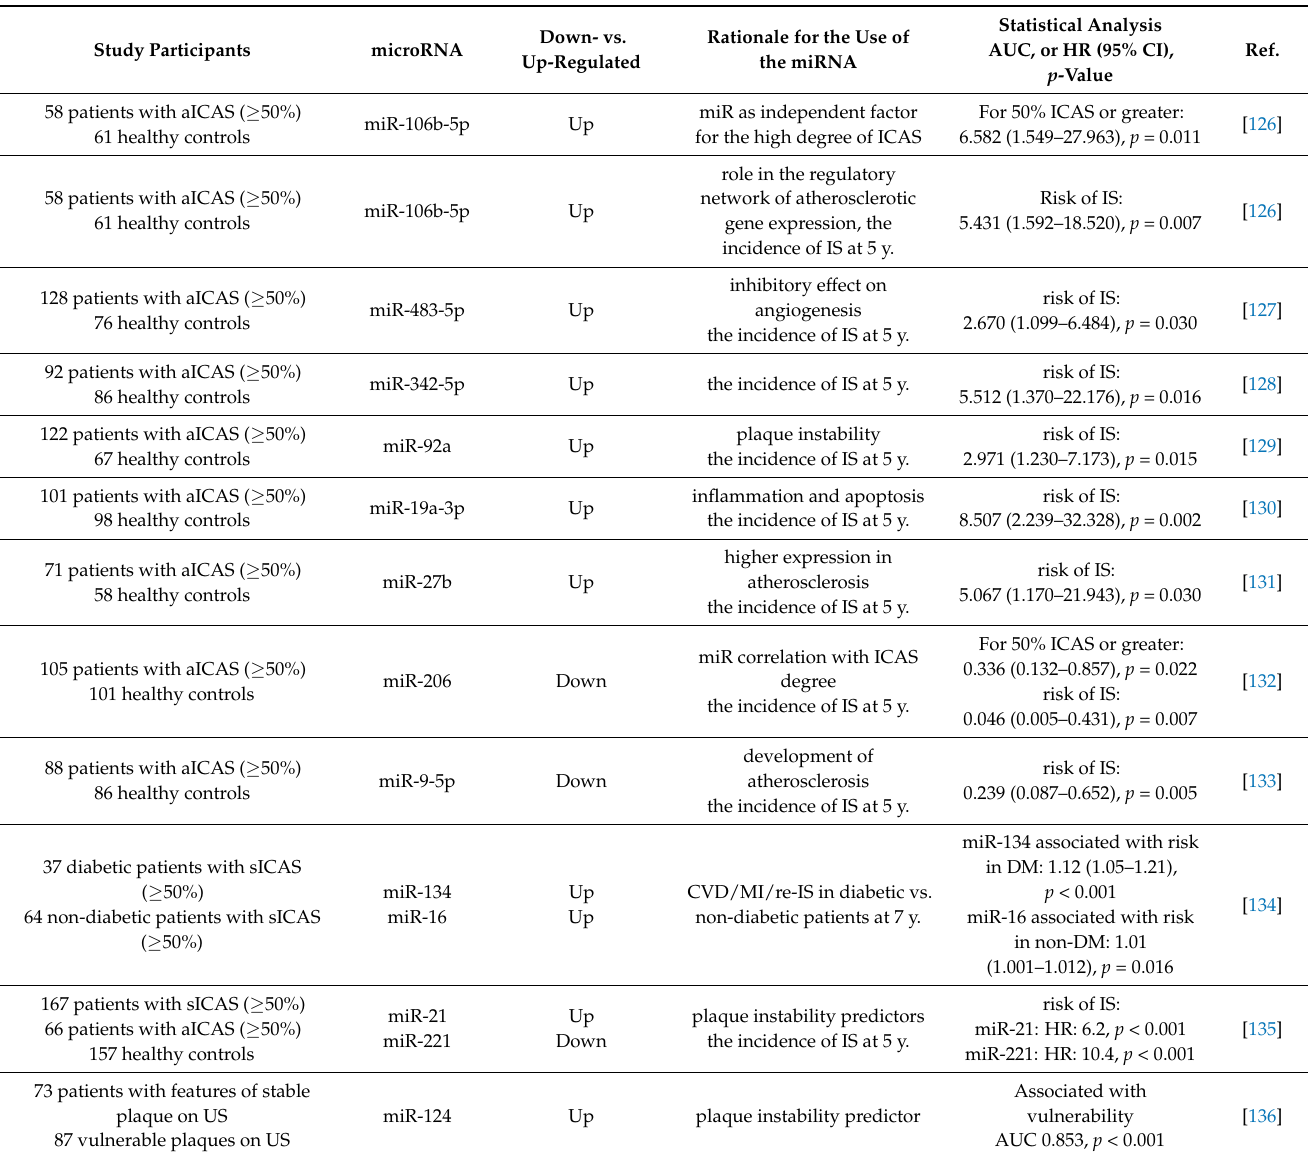
In the study by Dolz et al., the authors focused on the progression of asymptomatic ICAS and the potential role of miRNAs as non-invasive biomarkers of carotid plaque instability and ICAS progression [121]. The analysis identified a different miRNA expression profile in RNA samples from patients with ICAS progression during the follow-up period, compared to the patients without ICAS progression. Progression of ICAS was associated with significantly